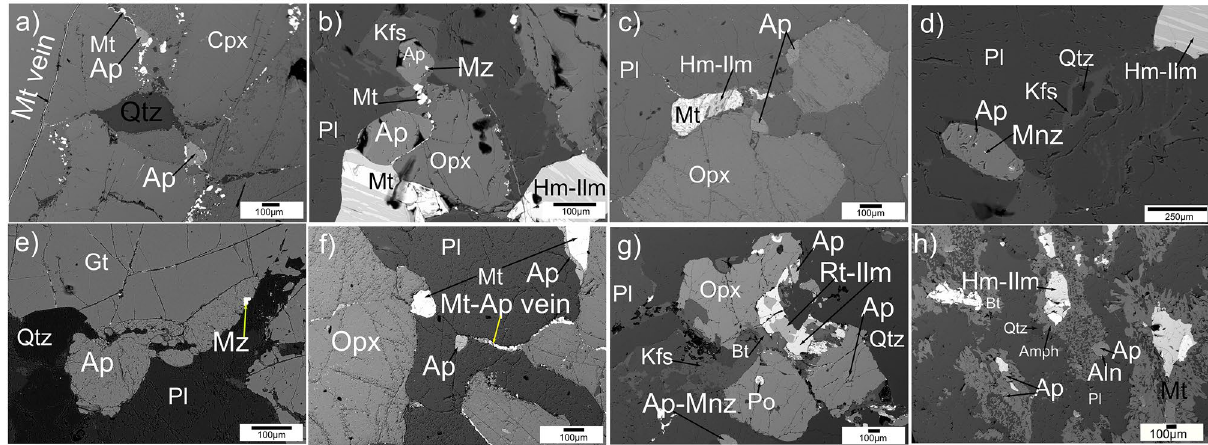
Figure 2. High contrast back-scattered secondary electron (BSE) imaging of phosphate-silicate-oxide- sulfide mineral textures using an Electron Probe Micro Analyzer (EPMA). In metagabbro and two-pyroxene granulite, apatite occurs in equilibrium with ( a ) clinopyroxene-magnetite-quartz, ( b ) orthopyroxene-hemo- ilmentite-Mt-feldspars, where the apatite grain is surrounded by K-feldspar veins, ( c ) orthopyroxene-hemo- ilmentite-Mt-feldspars, ( d ) hemo-ilmenite-plagioclase-K-feldspar-quartz; ( e ) garnet-plagioclase-quartz, ( f ) orthopyroxene-plagioclase-magnetite, and ( g ) in charnockite, apatite exists in equilibrium with orthopyroxene- rutile-ilmenite-biotite-feldspar-quartz; ( h ) in Hb-Bt gneiss, apatite is associated with hemo-ilmenite-magnetite- biotite-hornblende-plagioclase-quartz. Qtz quartz, Plg plagioclase, Kfs K-feldspar, Opx orthopyroxene, Cpx clinopyroxene, Gt garnet, Amph amphibole, Bt biotite, Hm-Ilm hematite–ilmenite exsolutions. Mt magnetite, Ilm-Rt ilmenite-rutile assemblage, Po pyrrhotite, Ap apatite, Aln alanite, and Mnz monazite. This figure is created using Inkscape version 0.92.2 (https:// inksc ape.